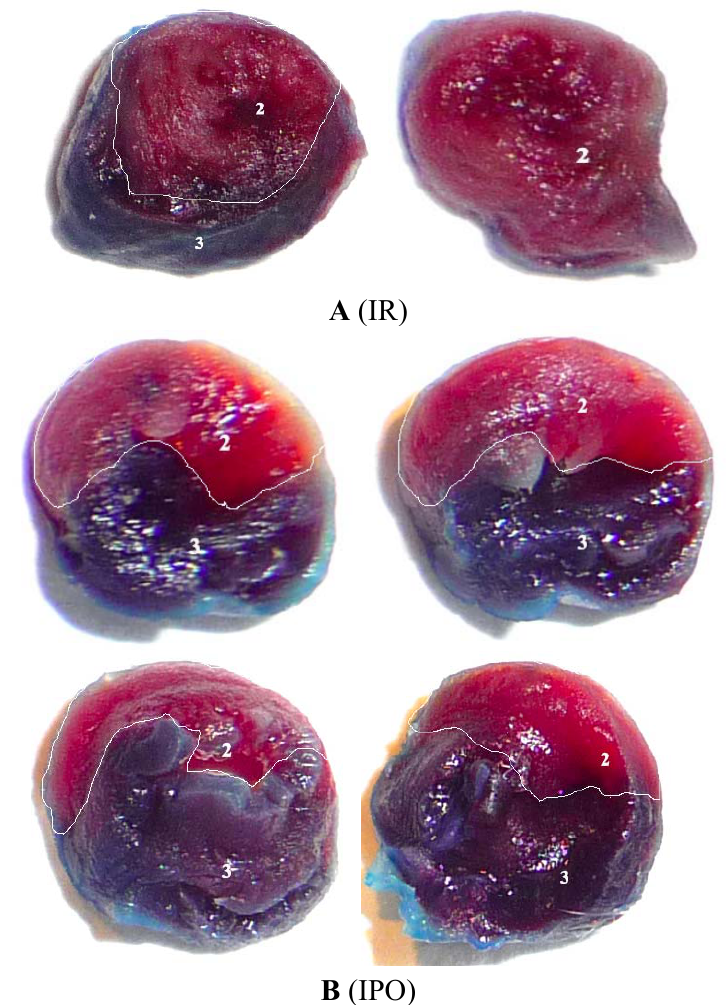
Figure 1. Effects of ischemic postconditioning on infarction.